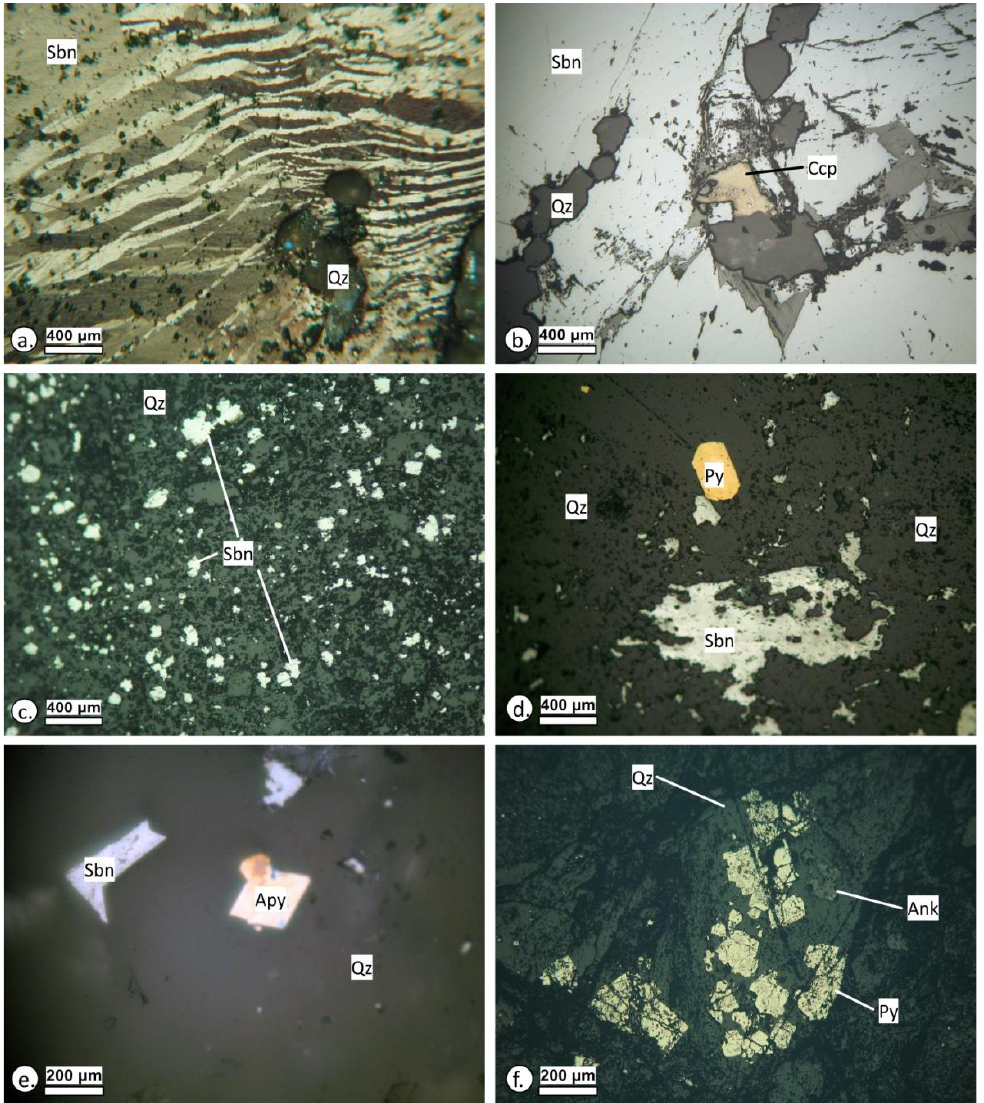
Figure 9. Photomicrographs of the stibnite mineralization from Rizana, under plane reflected light (Nichols crossed: ( a ), Nichols parallel: ( b – f )): ( a ) Massive stibnite (Sbn) showing pressure lamellae and quartz (Qz); ( b ) Massive stibnite (Sbn) cementing euhedral quartz (Qz). Chalcopyrite (Ccp) occurs in stibnite; ( c ) stibnite (Sbn) as disseminations in quartz (Qz); ( d ) Stibnite (Sbn) fills a cavity in quartz (Qz), where also euhedral pyrite (Py) is found; ( e ) Stibnite (Sbn) filling interstices and euhedral arsenopyrite (Apy) in quartz (Qz); ( f ) Euhedral pyrite (Py) showing cataclasis in quartz (Qz) grains, where ankerite (Ank) also occurs in a cavity. Table 2. SEM – EDS analysis and mineral formulas of stibnite, pyrite, sphalerite and chalcopyrite. Mineral Mineral formulas